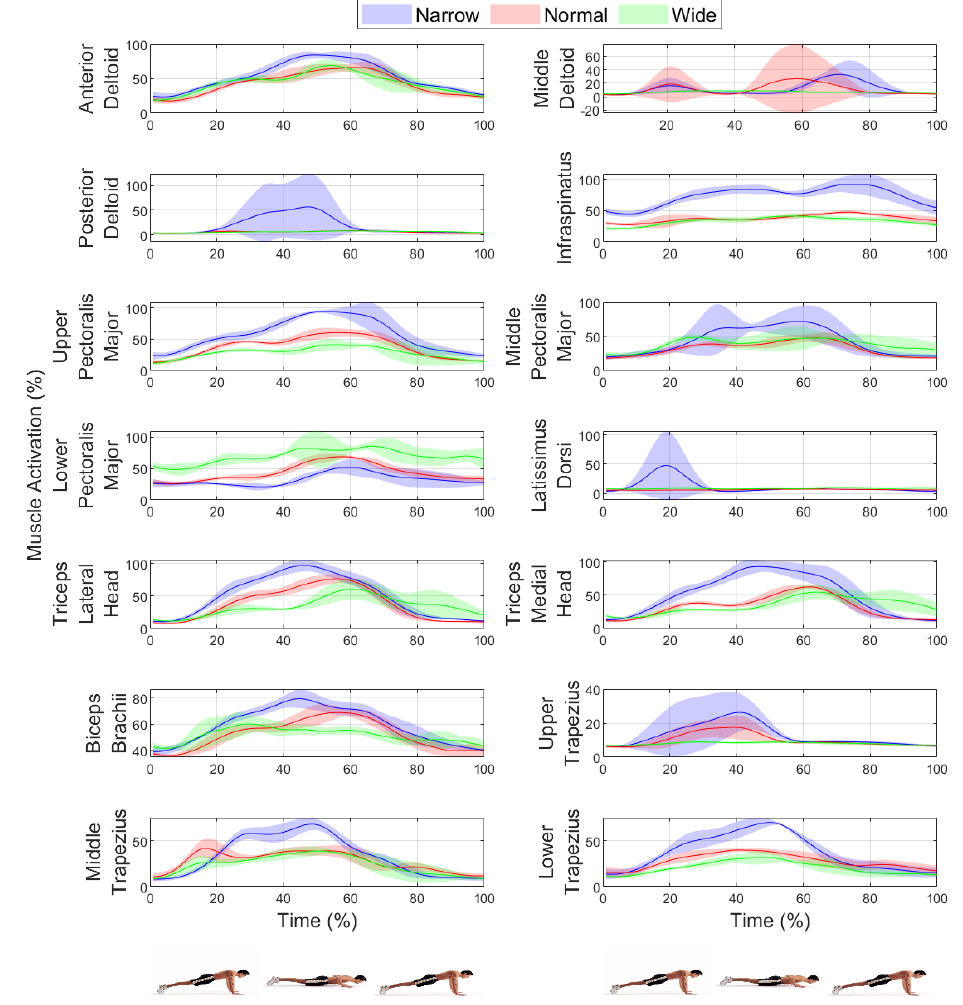
Figure 2. The mean and standard deviation of muscle activities for 14 muscles: the anterior deltoid, middle deltoid, posterior deltoid, infraspinatus, upper pectoralis major, middle pectoralis major, lower pectoralis major, latissimus dorsi, triceps lateral, triceps medial, biceps brachii, upper trapezius, middle trapezius, and lower trapezius muscles during the push-up exercise in three medial-lateral positions of palms (narrow, normal, and